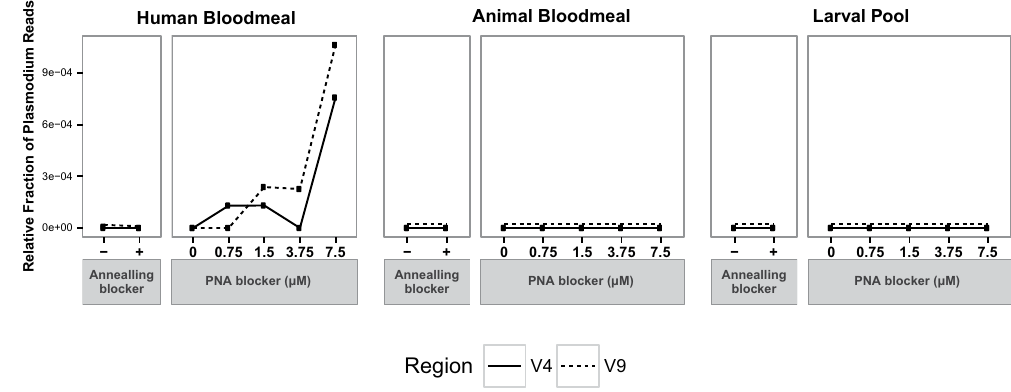
Figure 6. Positive control test of blocking strategies for detection of a known eukaryotic microbe. Relative fraction of 18s rRNA gene amplicons from the V4 (solid line) and V9 (dashed line) hypervariable regions assigned to the Plasmodium genus in the three samples under the different blocking conditions. All human bloodmeal-containing adult mosquito samples were positive for the presence of P . falciparum by molecular diagnostic assay. Dashed lines for Animal Bloodmeal and Larval Pool samples were superimposed with solid lines, and are shown offset to improve